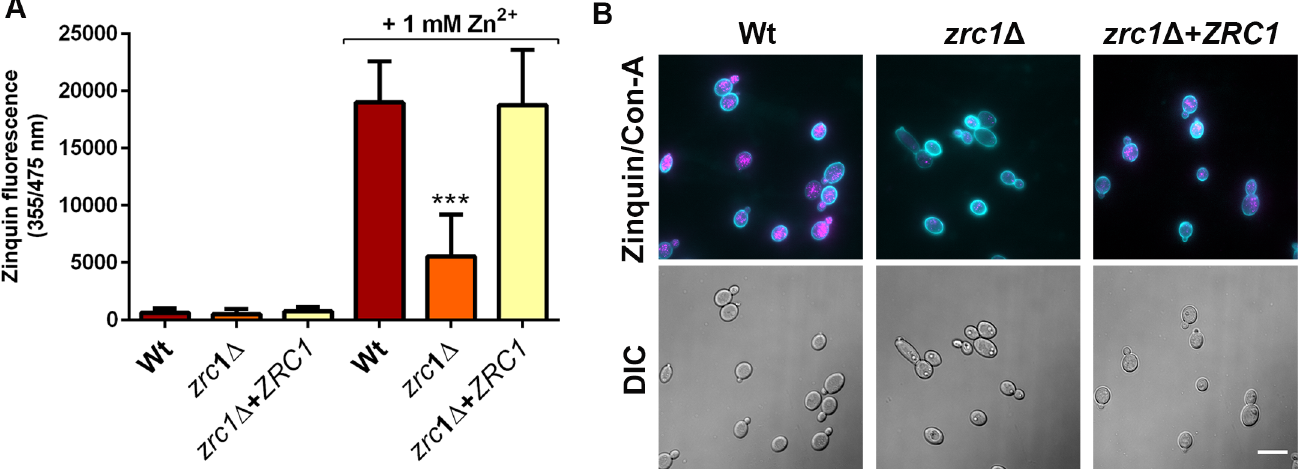
Fig 12. Relationship between Zrc1, zincosomes and zinc tolerance. (A) Cells were challenged with potentially toxic zinc (1 mM), stained with zinquin and fluorescence determined. P < 0.0001 compared to wild type and revertant. (B) Micrographs of cells treated as in A. Note that zrc1 Δ is highly defective for zincosome formation in response to 1 mM ZnSO 4 –a condition under which wild type, but not zrc1 Δ cells can grow (S7 Fig).